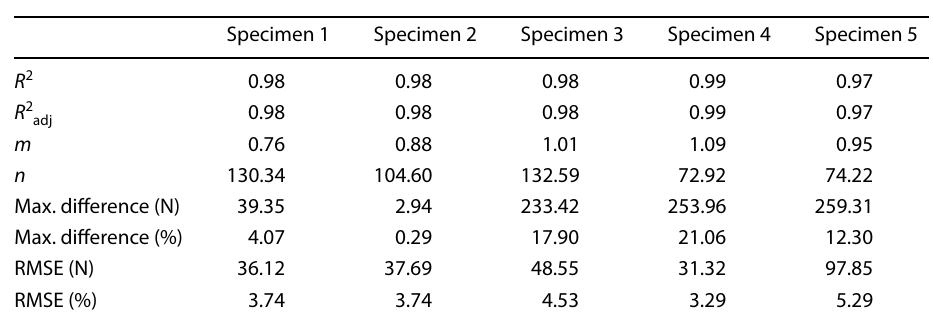
Table 5 Linear regression coefficients of model d (with greatest quantity of materials)